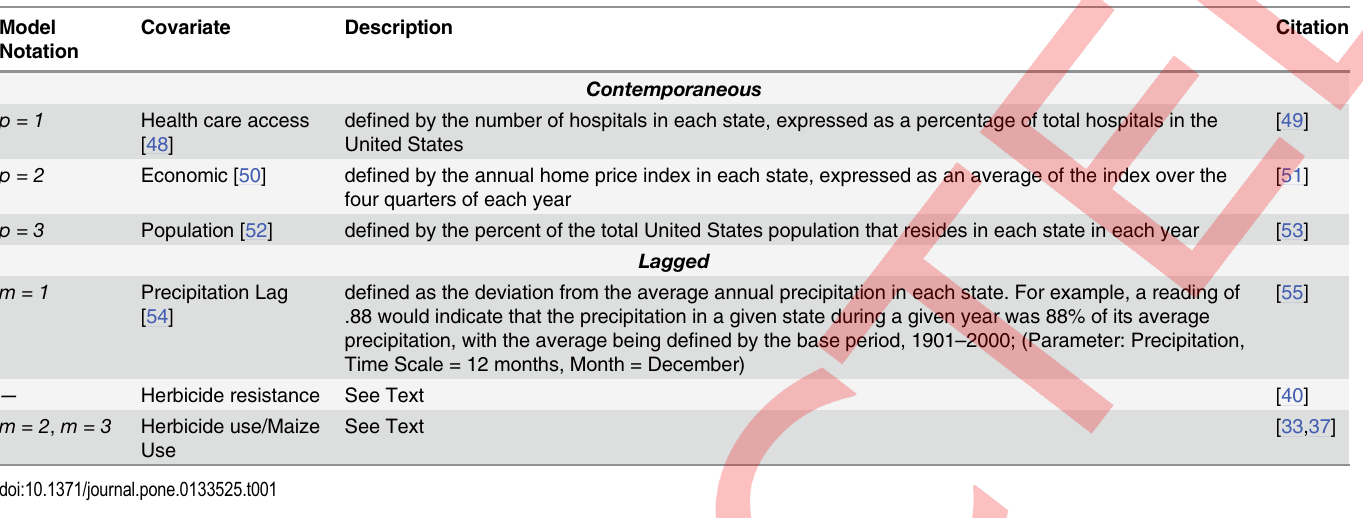
Table 1. Description of the covariate used, with a citation to explain the inclusion, in both the initial OLS screening and the fixed effects regression analysis for Models 1 and 2.